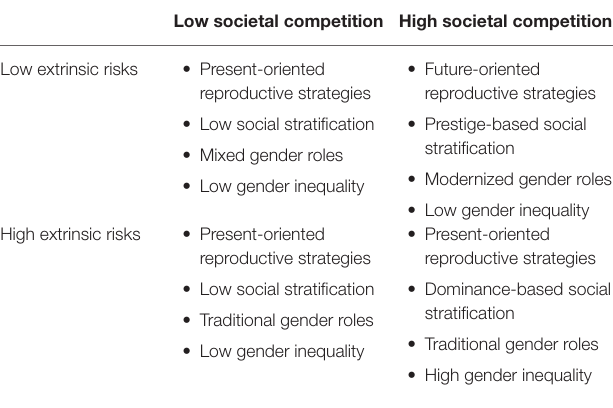
TABLE 1 | Summary of theoretical predictions of reproductive strategies, social structures, and gender relation outcomes in various environmental conditions. Low societal competition High societal